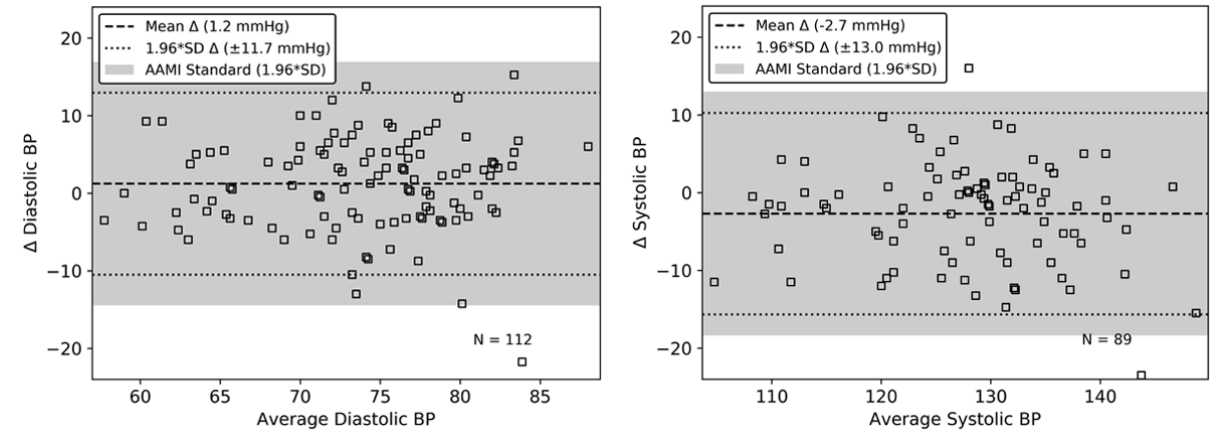
Figure 6. The toilet seated–based cardiovascular monitoring system has been shown to accurately measure blood pressure over an 8-week period. Both the diastolic (left) and systolic (right) blood pressure (BP) estimates from the seat exceed the accuracy required by the Association for the Advancement of Medical Instrumentation (AAMI) standard converted to a limits of agreement (shaded regions).